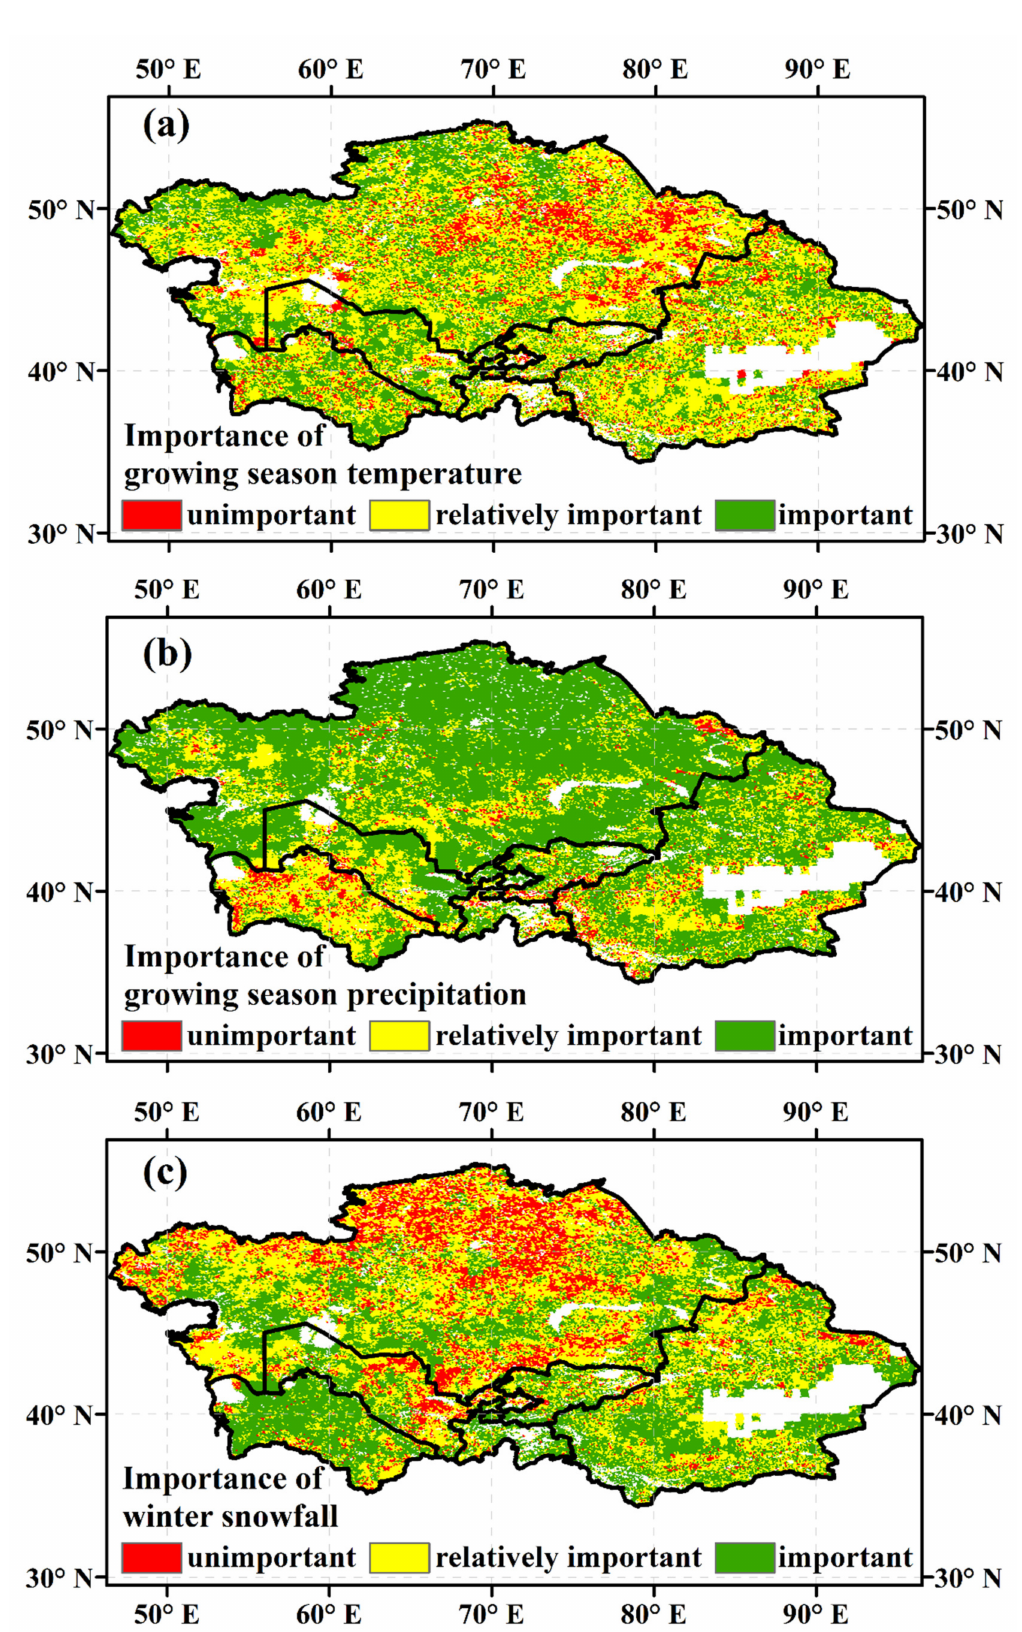
Figure 10. Importance of growing season temperature ( a ), precipitation ( b ), and winter snowfall ( c ) to vegetation growth for the period